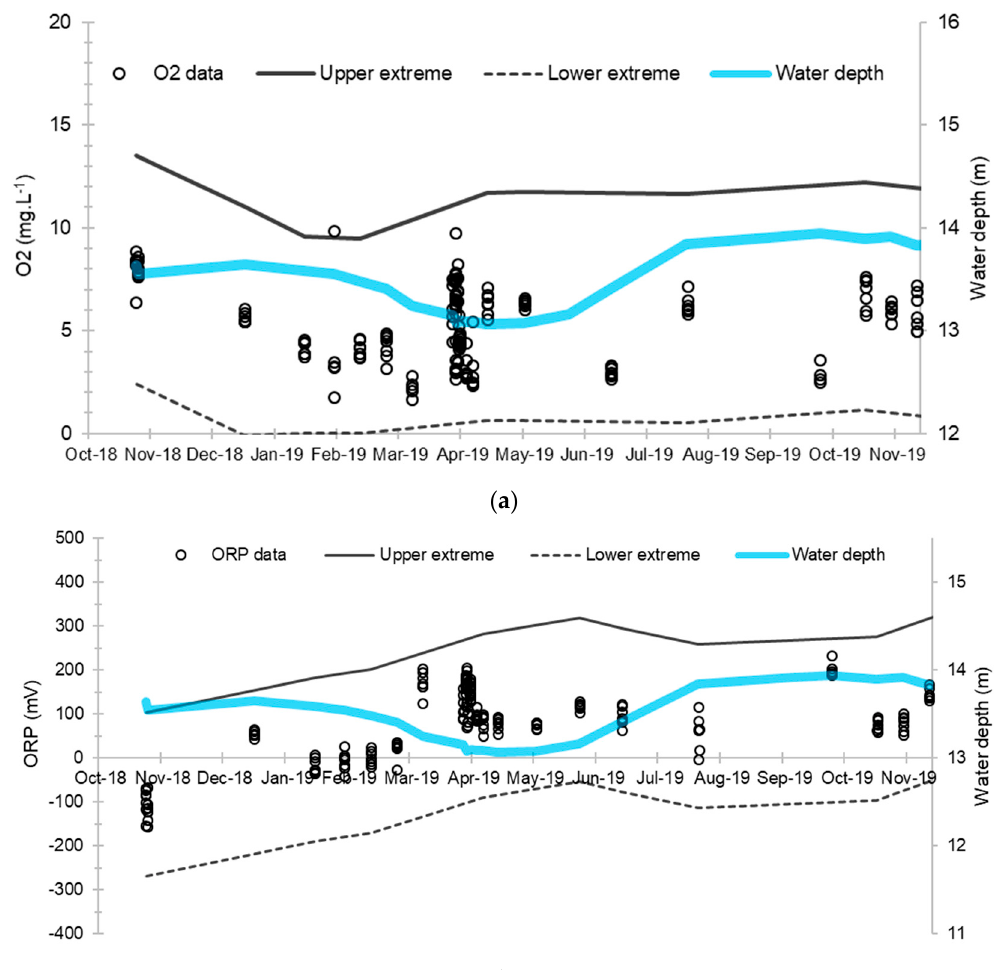
Figure 3. Boxplots of dissolved oxygen concentration and oxidation-reduction potential along the experimental site during the baseline: ( a ) Dissolved oxygen concentration; ( b ) oxidation-reduction potential. The colored boxes represent the 1st and 3rd quartiles (respectively Q1 and Q3), the black line is the median line, the dots are the measured values, the whiskers are the upper and lower extreme limits calculated according to the Tukey’s formula: Q1 + 1.5 (Q3 − Q1) and Q3 − 1.5 (Q3 − Q1).